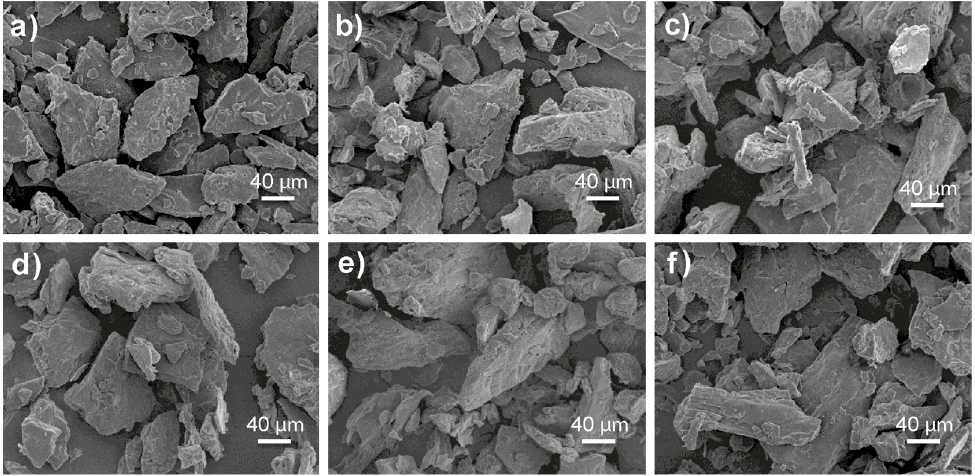
Figure 3. Micrographs of the extruded products from: ( a ) Mixture 1, ( b ) Mixture 2, ( c ) Mixture 3, ( d ) Mixture 4, ( e ) Mixture 5, ( f ) Mixture 6.